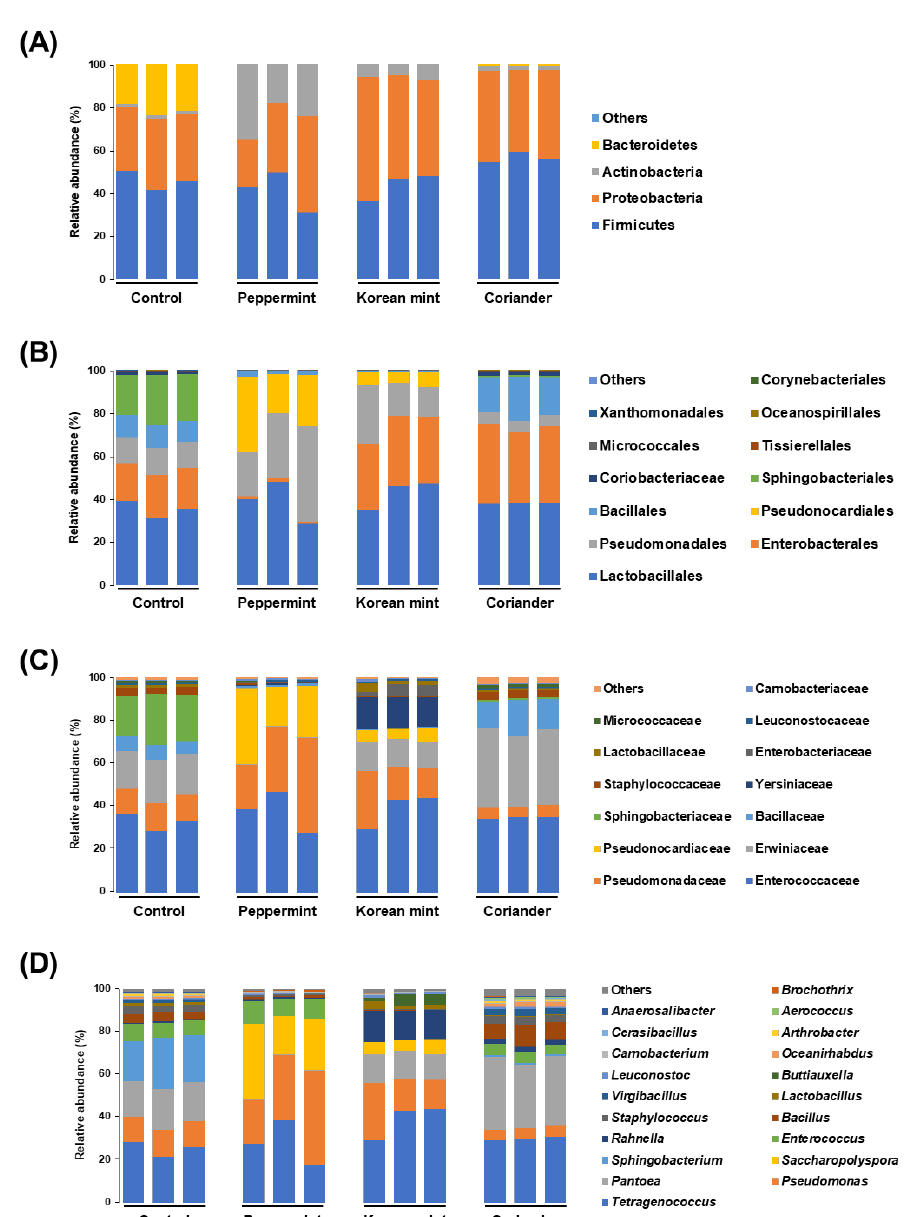
Figure 4. Stacked bar graphs representing the microbiome structure in soy paste samples prepared by adding Peppermint, Korean mint, and Coriander, relative to that of the control. ( A ) Phylum level, ( B ) order level, ( C ) family level, and ( D ) genus level.